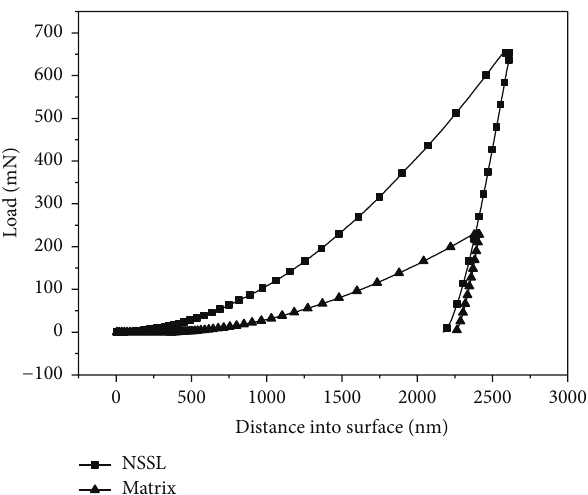
Figure 8: Load-depth curves of the NSSL and of the matrix.